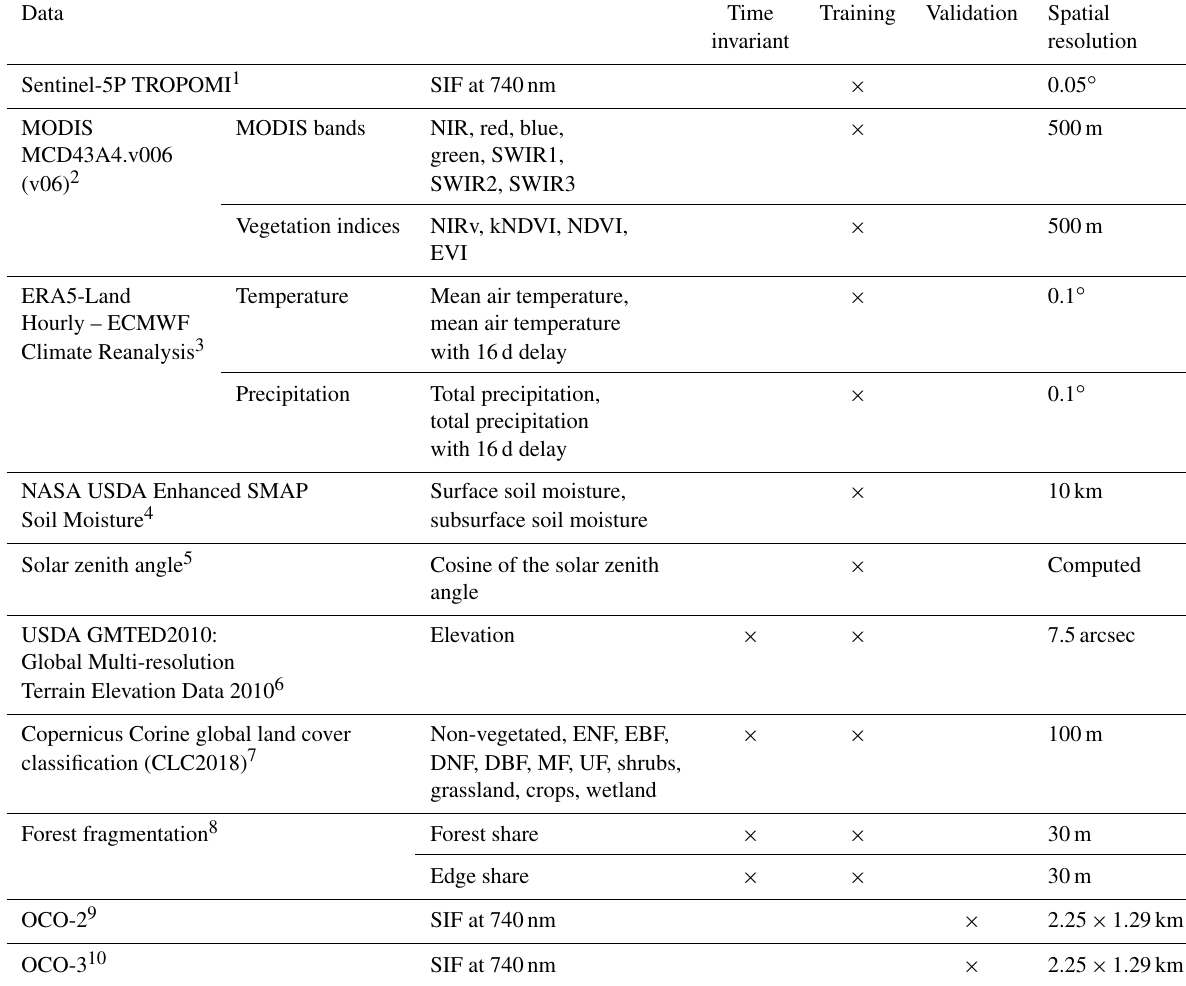
Table 1. Data sets used in this work. ENF: evergreen needleleaf forest; EBF: evergreen broadleaf forest; DNF: deciduous needleleaf forest; DBF: deciduous broadleaf forest; MF: mixed forest; UF: unknown